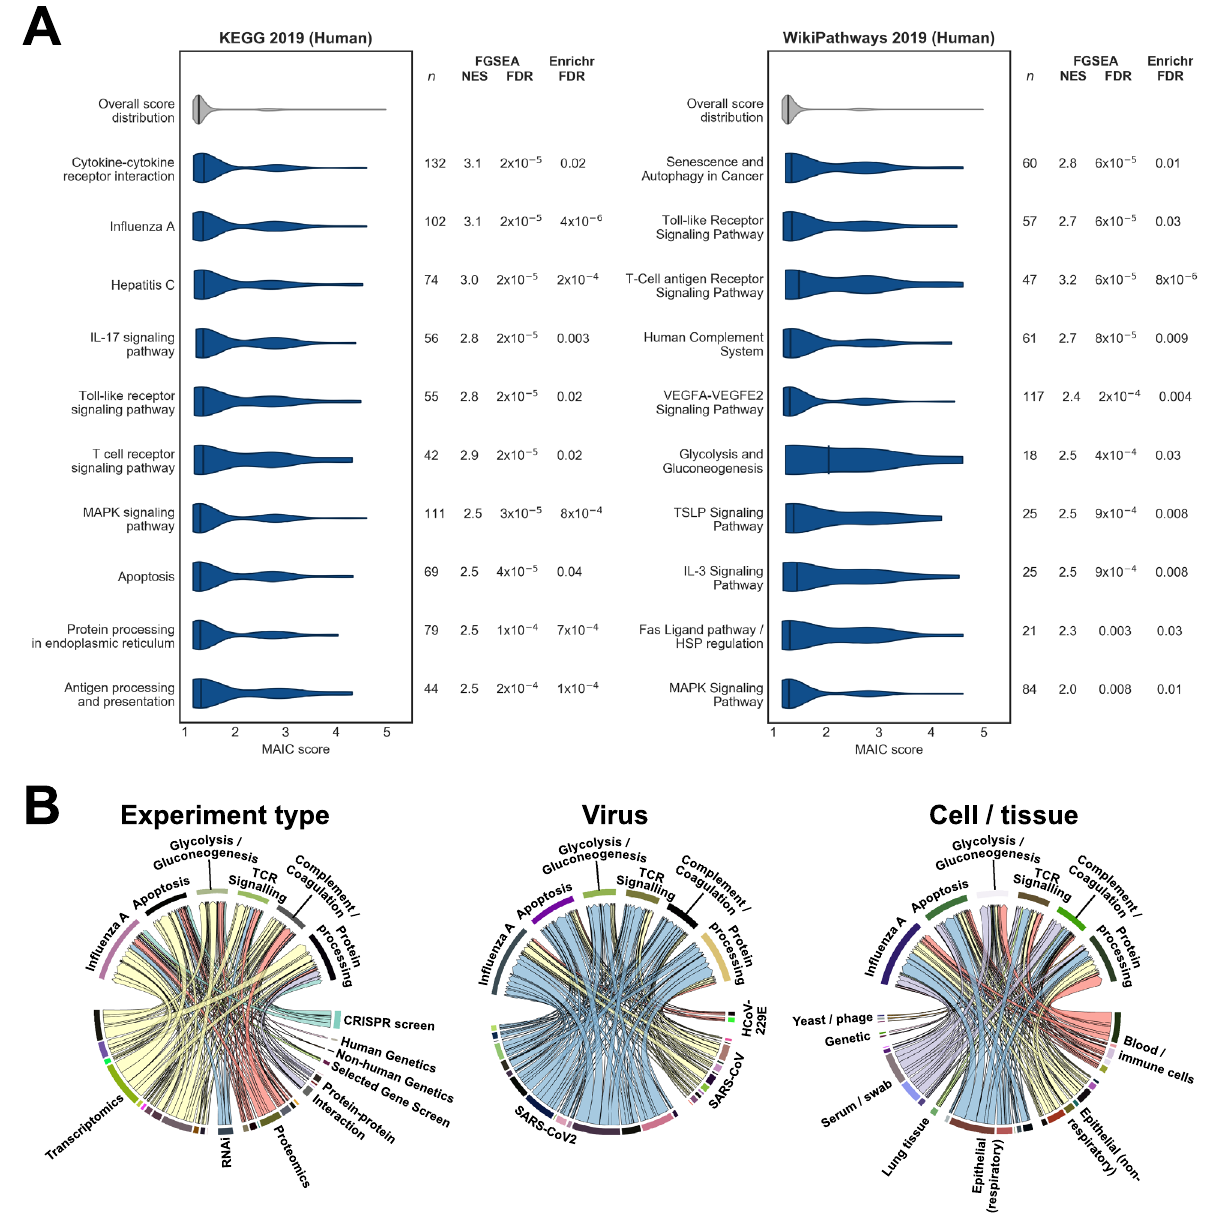
Figure 3. Gene Set Enrichment Analysis of MAIC rankings. ( A ) Violin plots of MAIC score distributions of top enriched pathways significant with both FGSEA and Enrichr algorithms, from the KEGG 2019 (Human) and WikiPathways 2019 (Human) databases. Highly similar pathways and irrelevant specific disease terms are not shown. n: number of gene set members included in the overall MAIC output; NES: normalised enrichment score from FGSEA. ( B ): Information contribution by methodology for selected enriched KEGG terms. Relative contributions of different information sources vary between functional annotations, but no single methodology predominates to drive